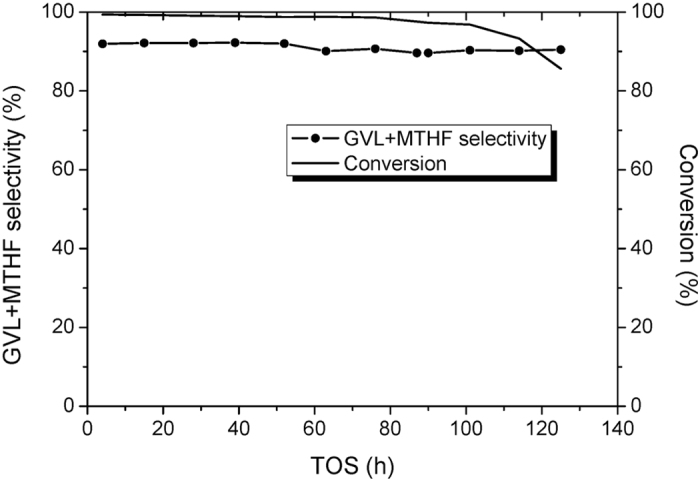
Catalytic performance of the Cu/SiO2 catalyst.